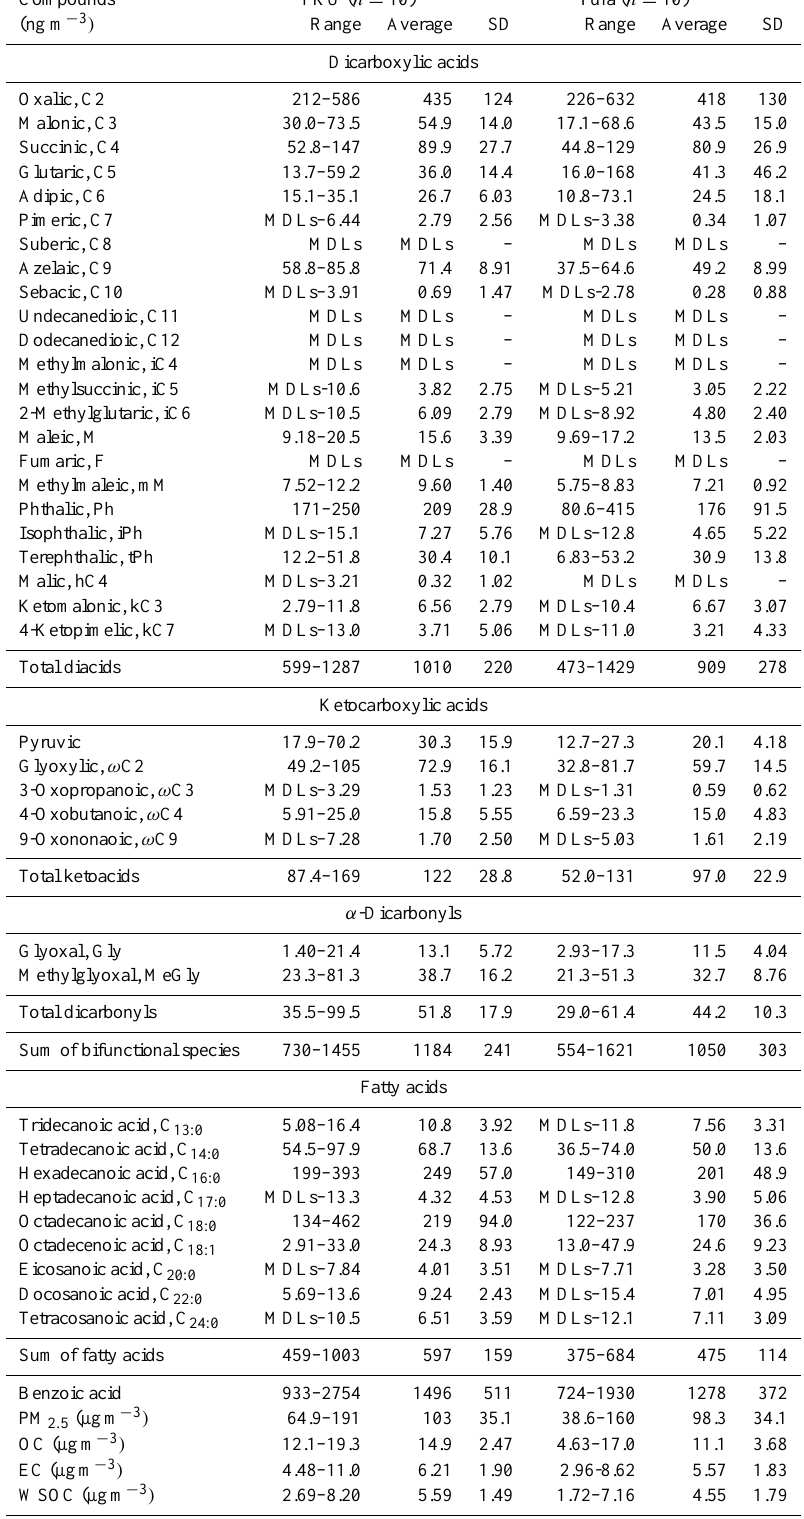
Table 1. Concentrations of dicarboxylic acids, ketocarboxylic acids and α -dicarbonyls, fatty acids and benzoic acid in PM 2 . 5 samples during CAREBeijing